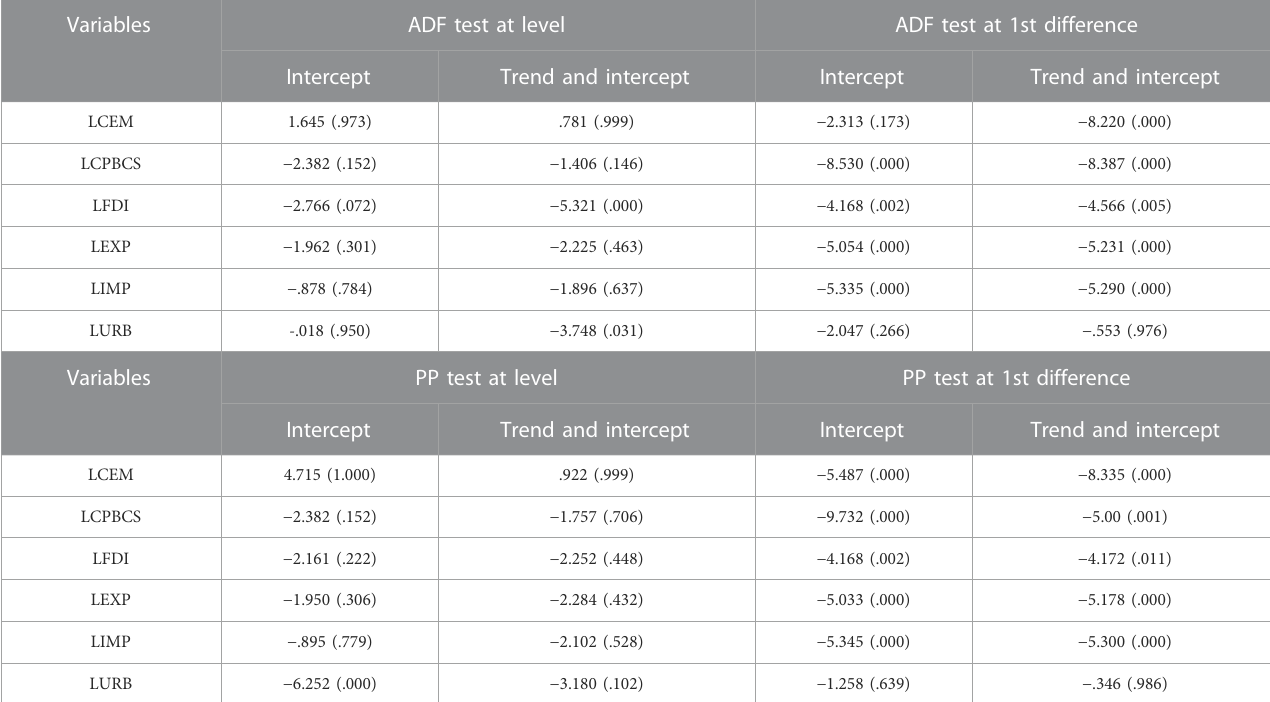
TABLE 3 ADF and PP unit root test.